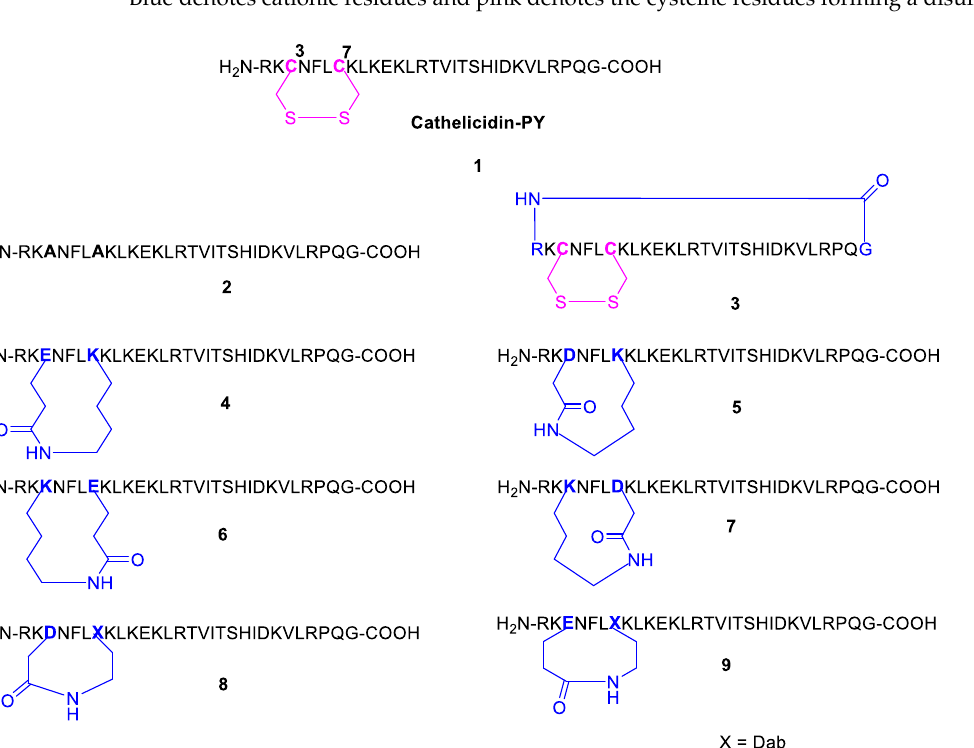
Figure 2. Structure of the cathelicidin-PY peptide, 1 , and a series of analogues, 2 – 9 of cathelicidin- PY. Dab = 2,4-diaminobutyric acid.